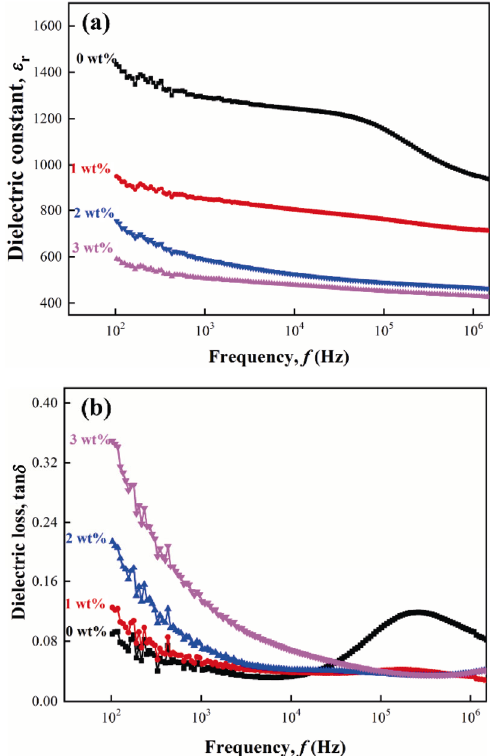
Fig. 7 Dielectric properties of the flash-sintered ZBM– x SiO 2 varistors ( x = 0–3 wt%) as a function of frequency with a preset maximum current of 3.0 A: (a) dielectric constant (  ), (b) dielectric loss (tan δ